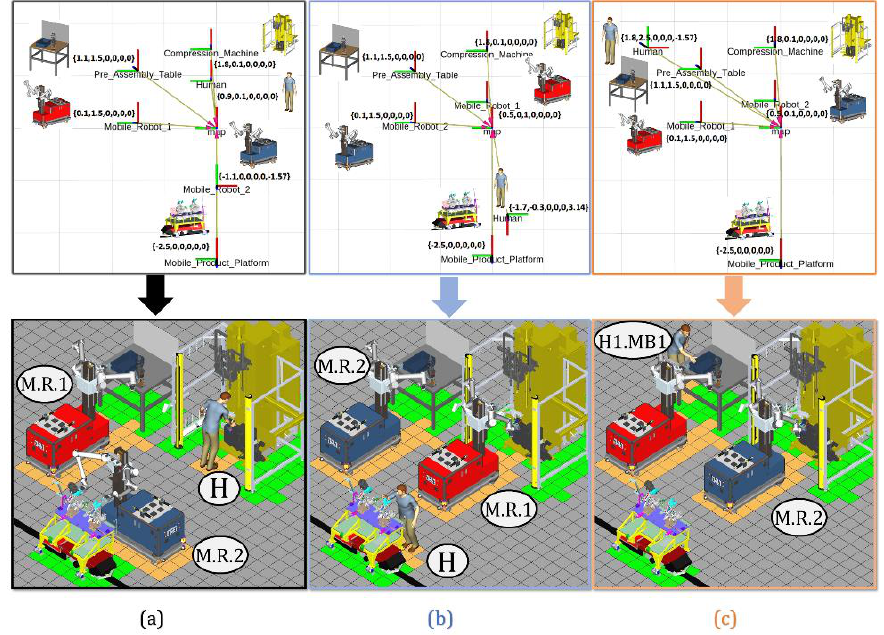
Figure 10. Indicative alternative configurations of the assembly system: ( a ) alternative 1, ( b ) alternative 2, ( c ) alternative 3.